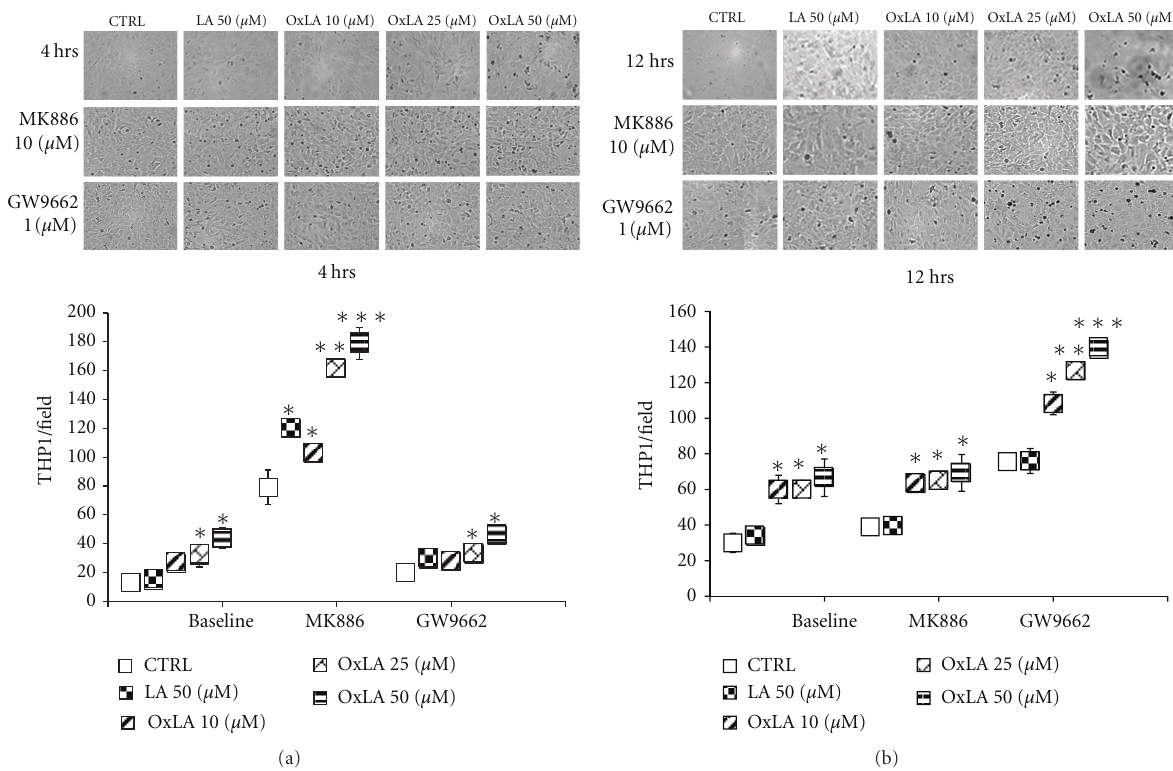
Figure 5: Alterations in Egr-1/MCP-1 by ω -6 lipids resulted in altered monocyte (THP1) adhesion to RASMCs THP1 (human monocyte) cells adhesion to RASMCs exposed to LA and OxLA (with or without pretreatment to MK886 and GW9662) was determined by counting the number of cells in a 3 × 3 field on an inverted fluorescent microscope. Results showed that monocyte adhesion reflected the alterations in Egr-1 and MCP-1 levels by ω -6 lipids by an increase in adherent monocyte cell number at 4hrs when PPAR α was downregulated and increase in adherent cell number at 12hrs when PPAR γ was downregulated. The data presented represents mean numbers of THP1 cells adhered to RASMCs in each field ± SEM (Standard Error of Mean). (a) monocyte adhesion at 4hrs; (b) monocyte adhesion at 12hrs. ∗ P < 0 . 05, ∗∗ P < 0 . 01, ∗∗∗ P < 0 .